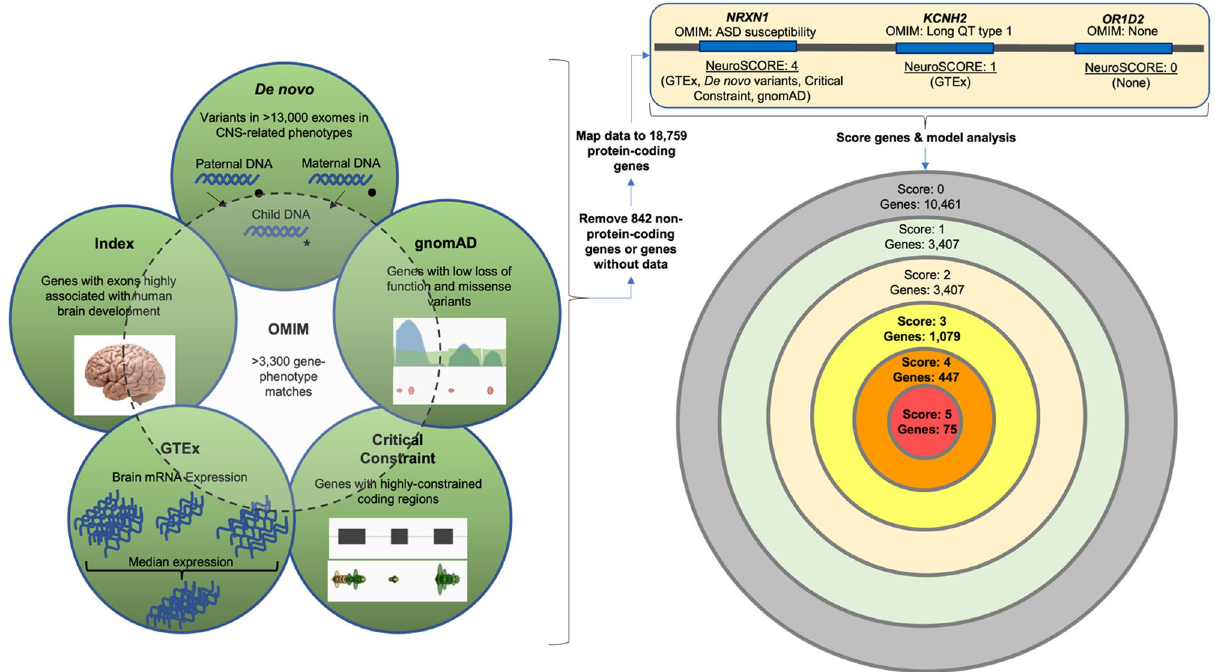
Figure 1. Schematic of final NeuroSCORE model. Key: De novo: De Novo Database; gnomAD: Genome Aggregation Database; Critical Constraint: Critically constrained coding regions database; GTEx: Gene-Tissue Expression database; Index: Database of genes based on Uddin et al. 66 ; OMIM: Online Mendelian Inheritance in Man database (see